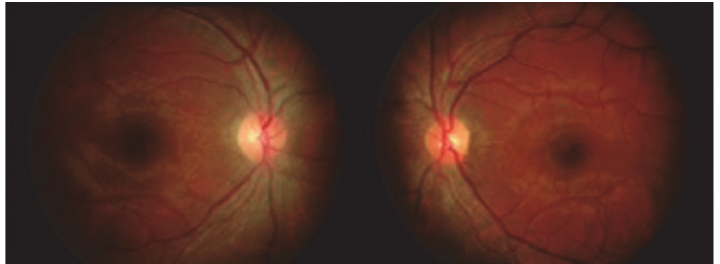
Figure 2: Fundus photo after three weeks of treatment showing regression of the optic disc swelling and splinter haemorrhages.